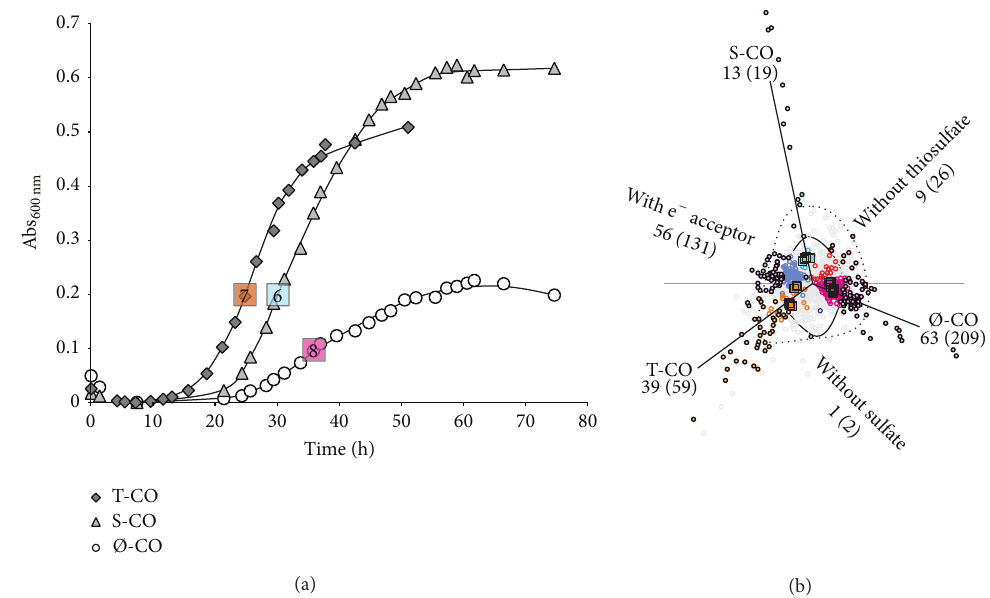
Figure 1: (a) Growth curves of cultures utilizing CO/CO 2 grown on either sulfate (S-CO), thiosulfate (T-CO), or without electron acceptor (Ø-CO). Numbers denote biological replicates for each growth condition. (b) A correspondence plot (PCA 1 and 2; 24.8% and 14.6% of total variance) of differentially regulated genes (circles) displaying significantly differentially regulated genes (ANOVA) in relation to growth conditions (total amount of differentially regulated genes in brackets). Filled circles and numbers outside brackets denote differentially expressed genes above 1.5-fold. Outlined area shows differential expression above 1.5- and